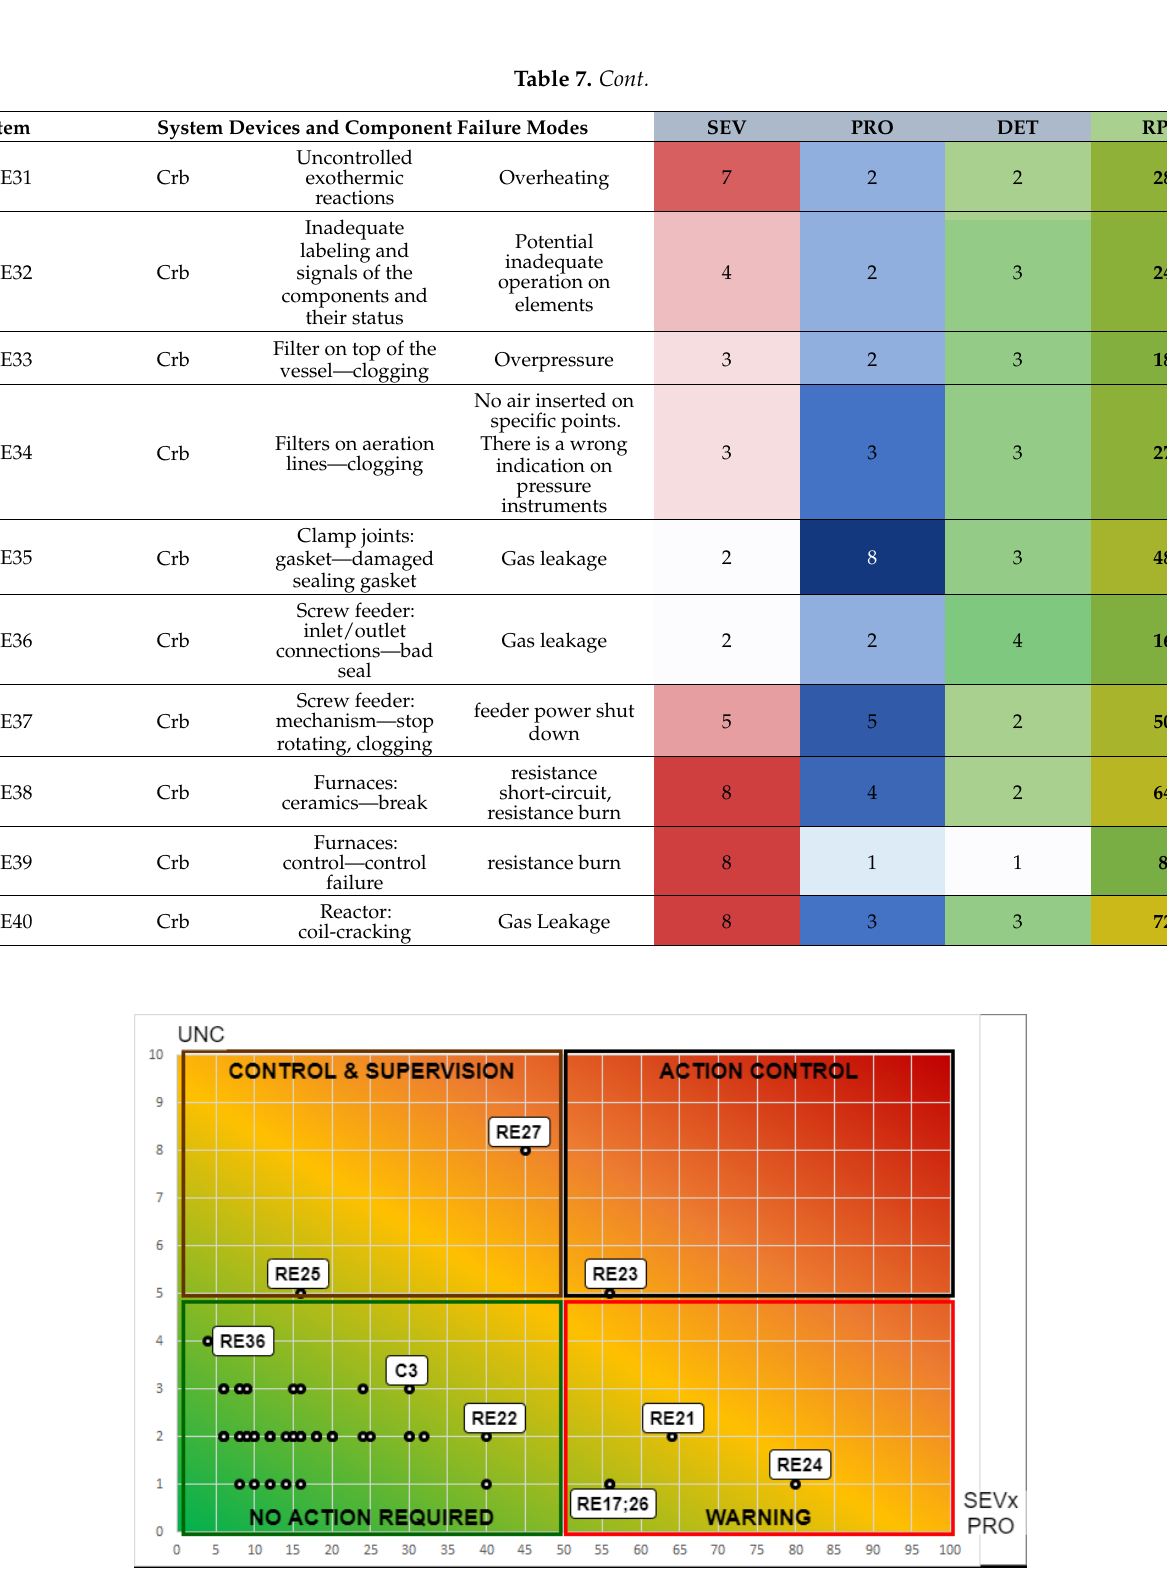
Figure 5. FMEA Assessment Map. Note that the x -axis represents the product of severe (SEV) and probability (PRO), while the y -axis represents the uncertainty (DET) produced by lack of failure detection.